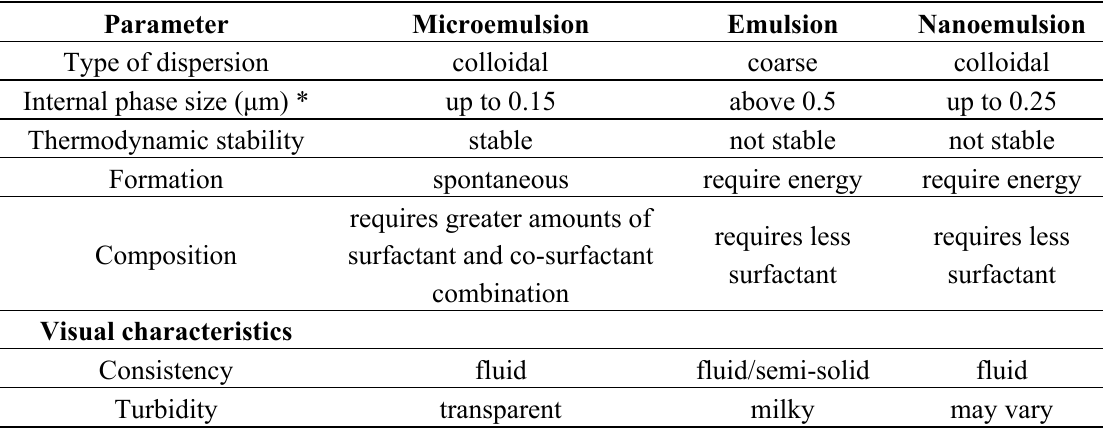
Table 1. Comparison of microemulsions with emulsions and